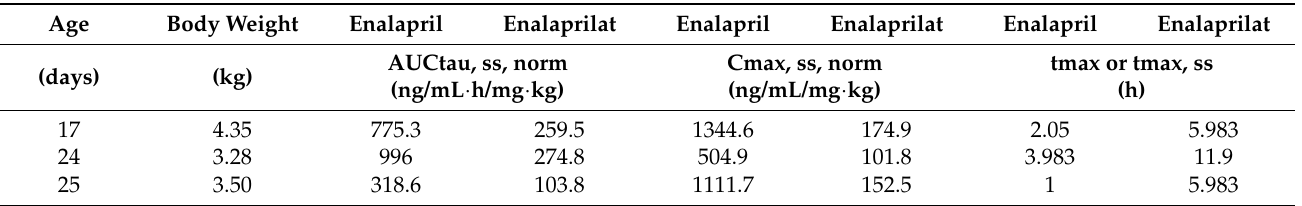
Table 3. Individual age, body weight and pharmacokinetic parameters of the four male neonates with congenital heart defects below 28 days of age.